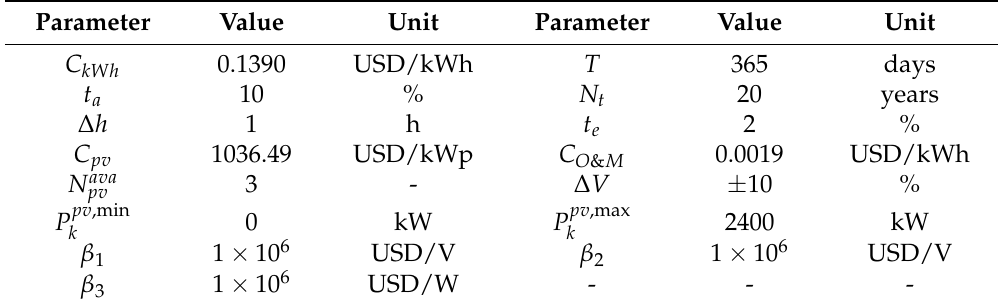
Table 1. Information used to calculate the objective function